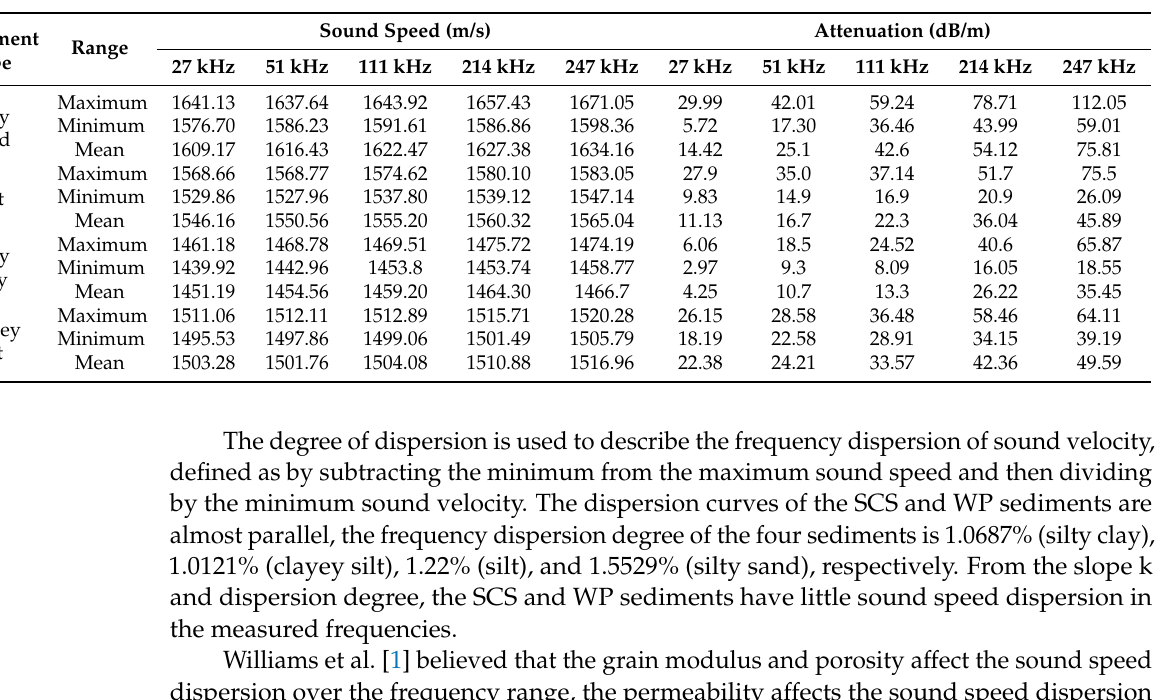
Table 1. The measured sound speed and attenuation at different